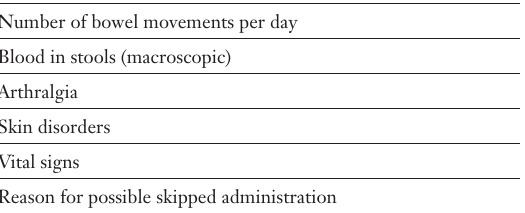
Table 5 Evaluation of efficacy and safety of home careTNF- α